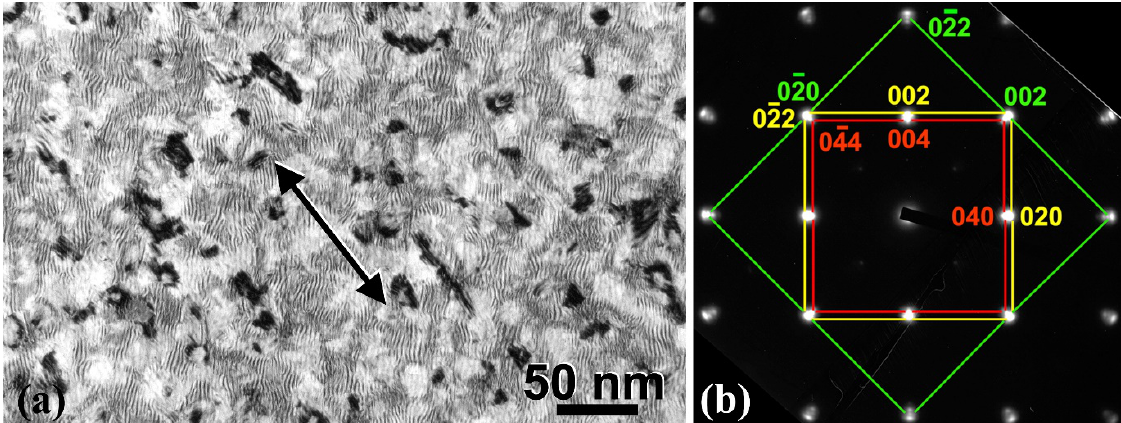
Figure 4. ( a ) Plan-view TEM micrograph showing the distribution of Fe 3 O 4 nanoparticles at the Fe/Pt interface, along the [100] Fe-Fe 3 O 4 -Pt projection direction. Parallel moiré fringes emerge as a result of overlapping of the Fe and Pt slightly mismatched lattices. ( b ) The corresponding common SAED pattern, showing the epitaxial relation of the three involved lattices (Fe: green, Pt: yellow, Fe 3 O 4 : red) along the growth axis. The lateral side of nanoparticles is oriented roughly along the <0–10>Fe/<0–11>Pt direction, shown by the arrow in ( a ), whereby lateral dimensions greater than 10–15 nm are due to bunched nanoparticles.